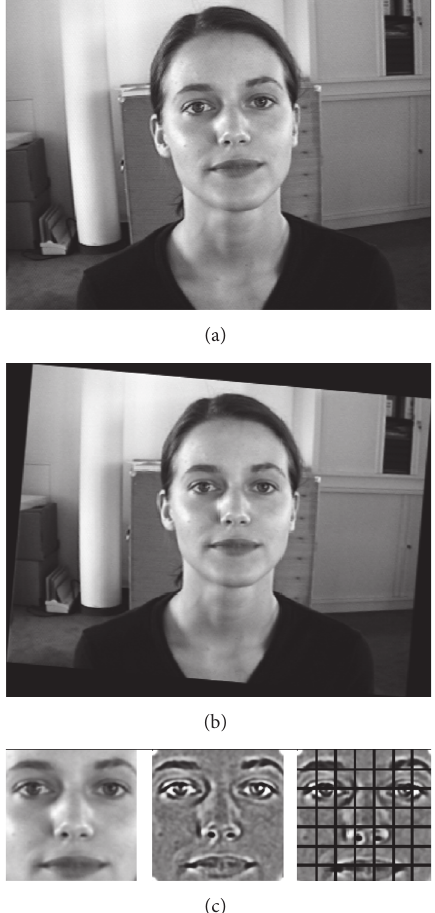
Figure 2: Example image from the BioID face database [18]. The original image (a) is first rotated based on the eye locations (b). The resulting image is scaled, eye locations are fixed, and a 128 × 128 pixel face region is extracted ((c) left). The lighting is normalized ((c) middle) and the face is divided into 7 × 7 rectangular regions ((c) right). LBP histograms are computed for each region separately and combined into a spatially enhanced